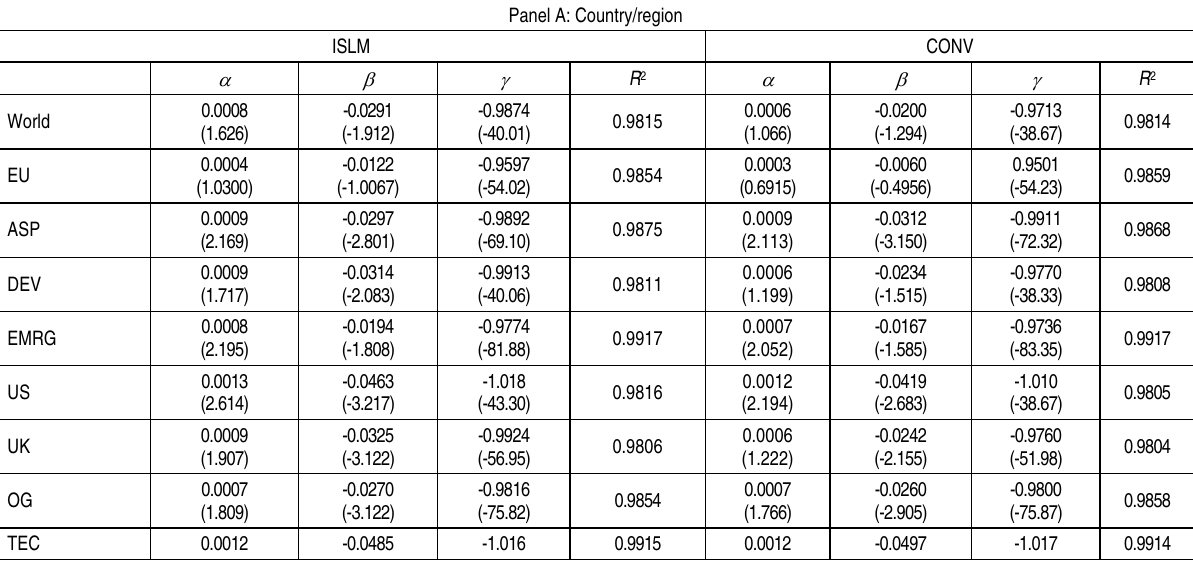
Table 7. Treynor and